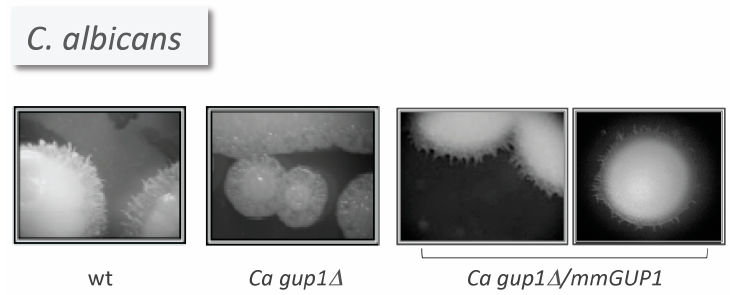
Figure 5. Mus musculus HHATL complementation of C. albicans colonies hyphae defect caused by the double deletion of GUP1 alleles [29,156]. Pictures of colony borders were taken after 3 days of incubation in spider medium at 37 °C.